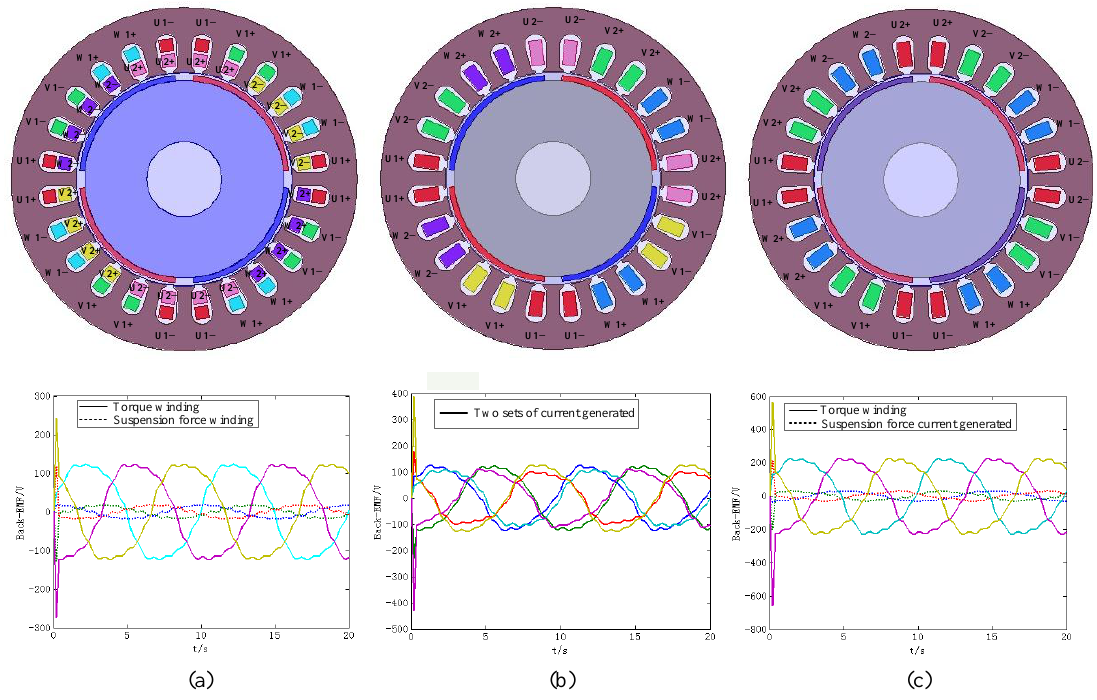
Figure 4. The no-load motional-EMF of a BPMSM with different winding structures. ( a ) The two sets of windings configuration; ( b ) The single winding configuration; ( c ) The improved T-shaped single winding configuration.